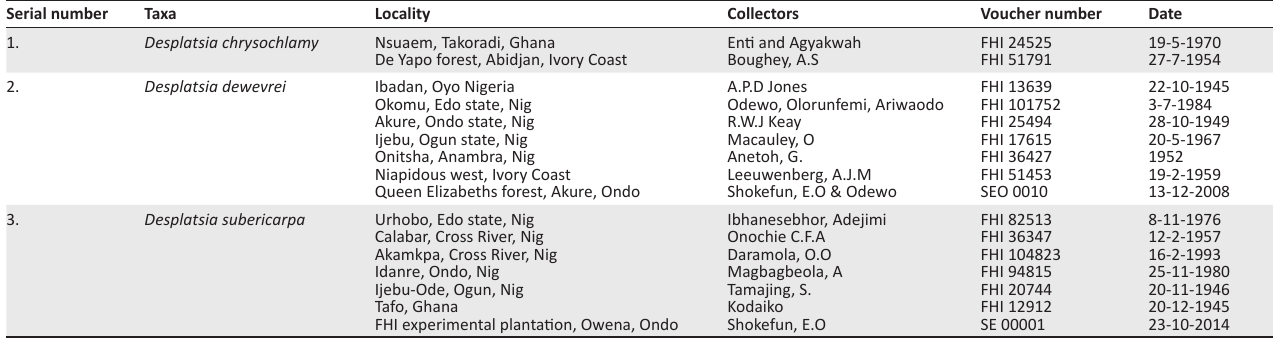
TABLE 1: List of Desplatsia specimens